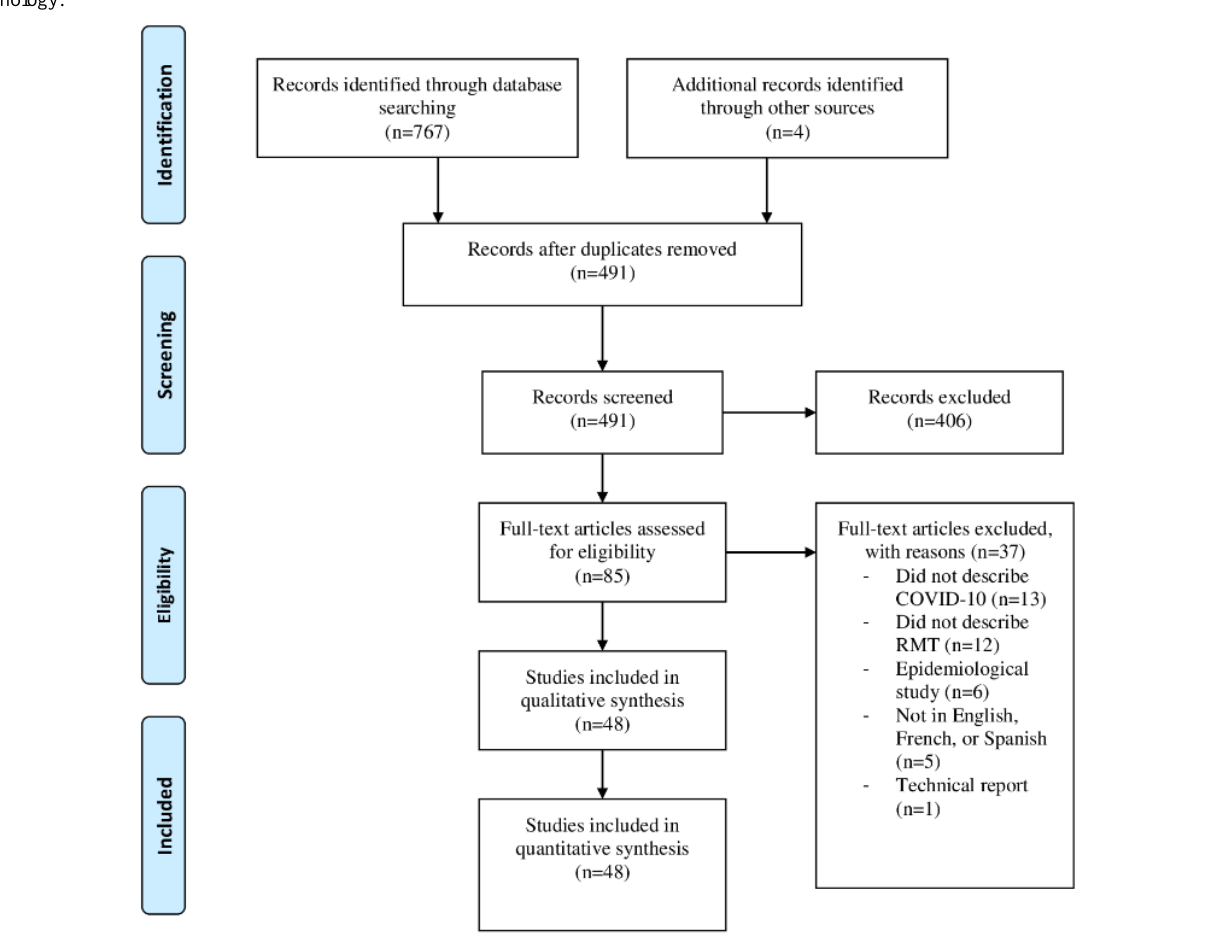
Figure 1. PRISMA 2009 flow diagram. PRISMA: Preferred Reporting Items for Systematic Reviews and Meta-Analyses; RMT: remote monitoring